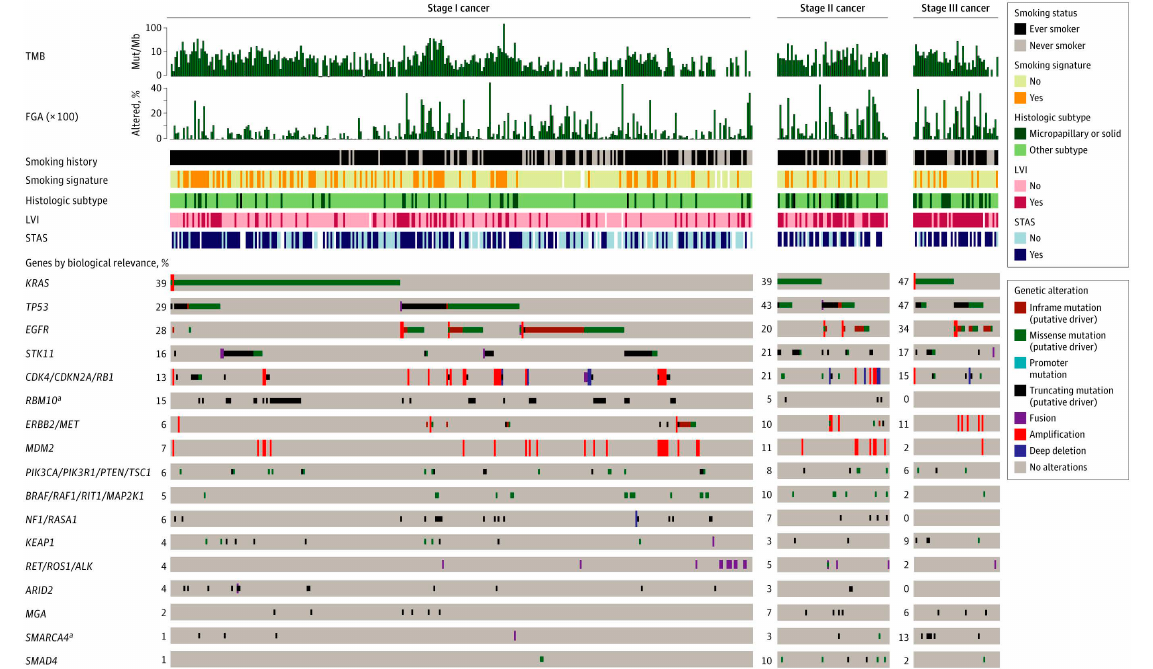
Figure 3. Oncoprint by pathologic stage with annotated clinicopathologic variables. Genes are grouped by biological relevance in lung adenocarcinoma. FGA, fraction of genome altered; LVI, lymphovascular invasion; Mut/Mb, mutations per megabase; STAS, spread through air spaces; TMB, tumor mutation burden. a p < 0.05, false-discovery rate, for difference in alteration frequency between stages using Fisher’s exact test. (From JAMA Surgery , Jones, G.D.; Brandt, W.S.; Shen, R.; Sanchez-Vega, F.; Tan, K.S.; Martin, A.; Zhou, J.; Berger, M.; Solit, D.B.; Schultz, N., “A genomic-pathologic annotated risk model to predict recurrence in early-stage lung adenocarcinoma.” Vol. 156, e205601–e205601. Copyright © (2021) American Medical Association. Reprinted with permission).